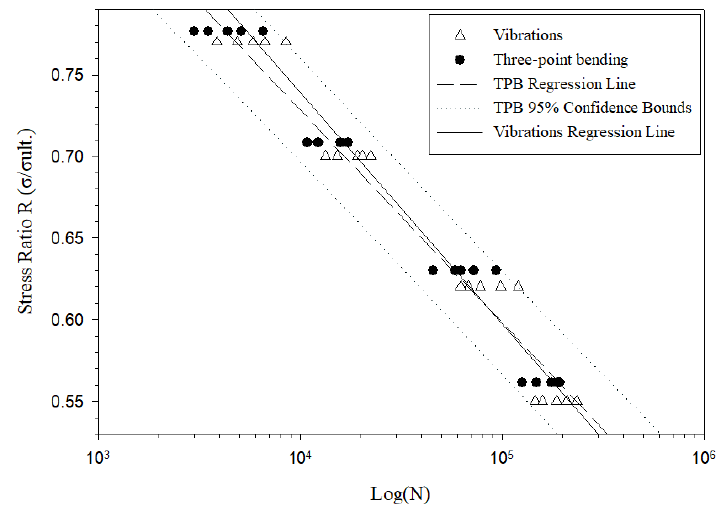
Figure 17. Fatigue lifetime S-N curves for Vibrations and Three-Point Bending. The TPB stress ratio calculation takes into account the effect of contact stress.